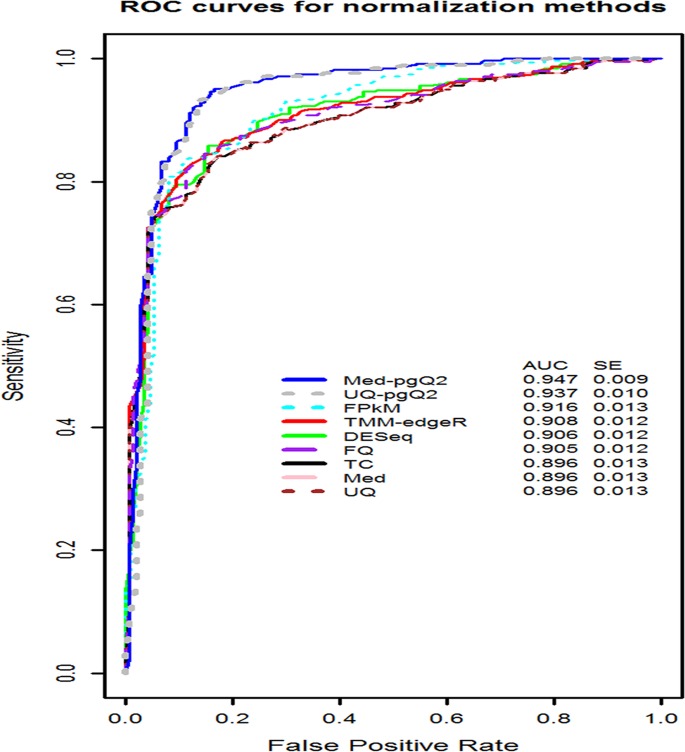
ROC curve and AUC values from MAQC2 data.The ROC curves and AUC values (inset) for evaluating the performance of the nine normalization methods were computed using MAQC2 with two conditions (uhr and hbr). Our proposed methods, Med-pgQ2 and UQ-pgQ2 (blue and grey, respectively) performed slightly better.